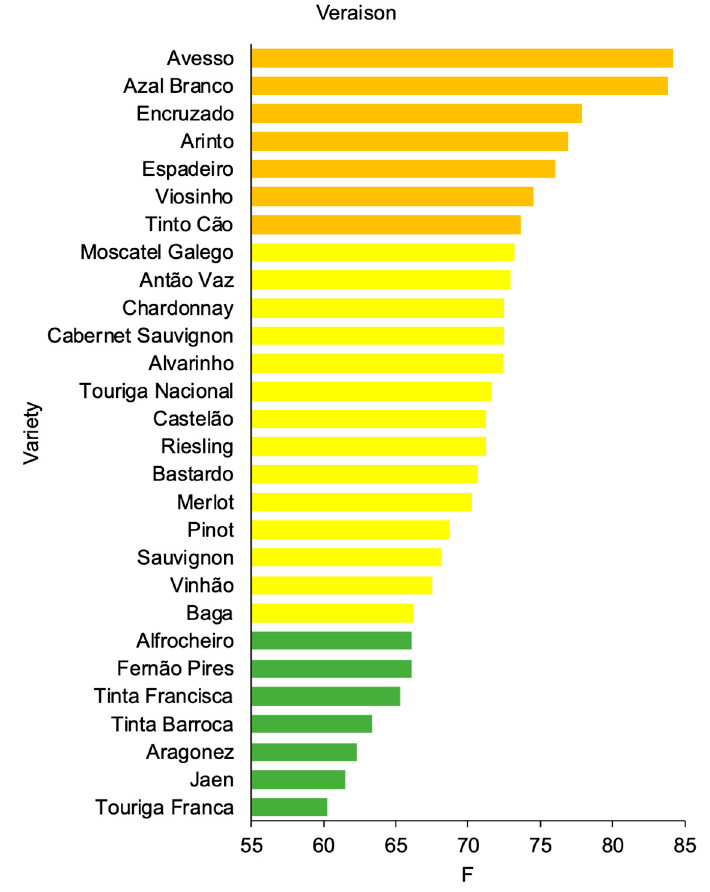
Figure 8. Ranking of the F measure for veraison by grapevine variety in the Lisboa wine region. Only models with EF ≥ 0.5 are shown. 386